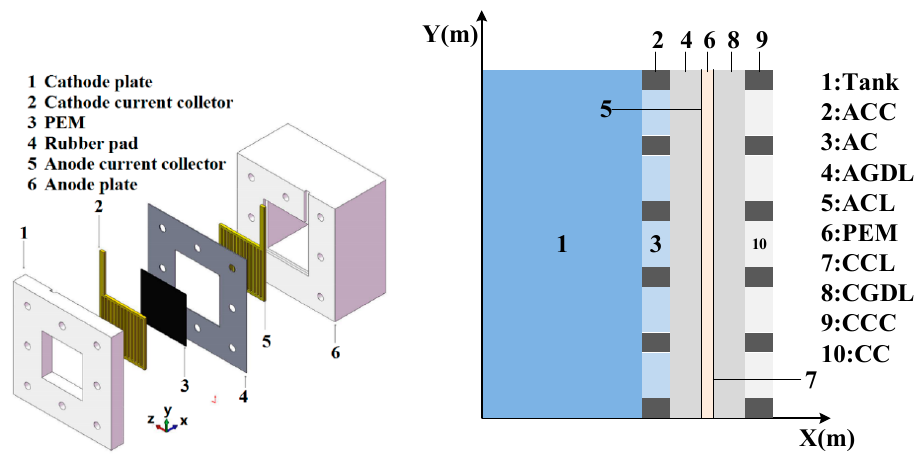
Figure 1. Simplified structure diagram of passive direct methanol fuel cell (DMFC).